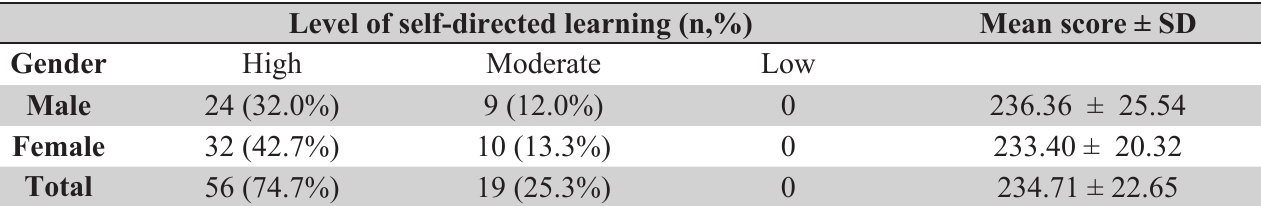
Table 2. Level of SDL in the students and obtained mean score